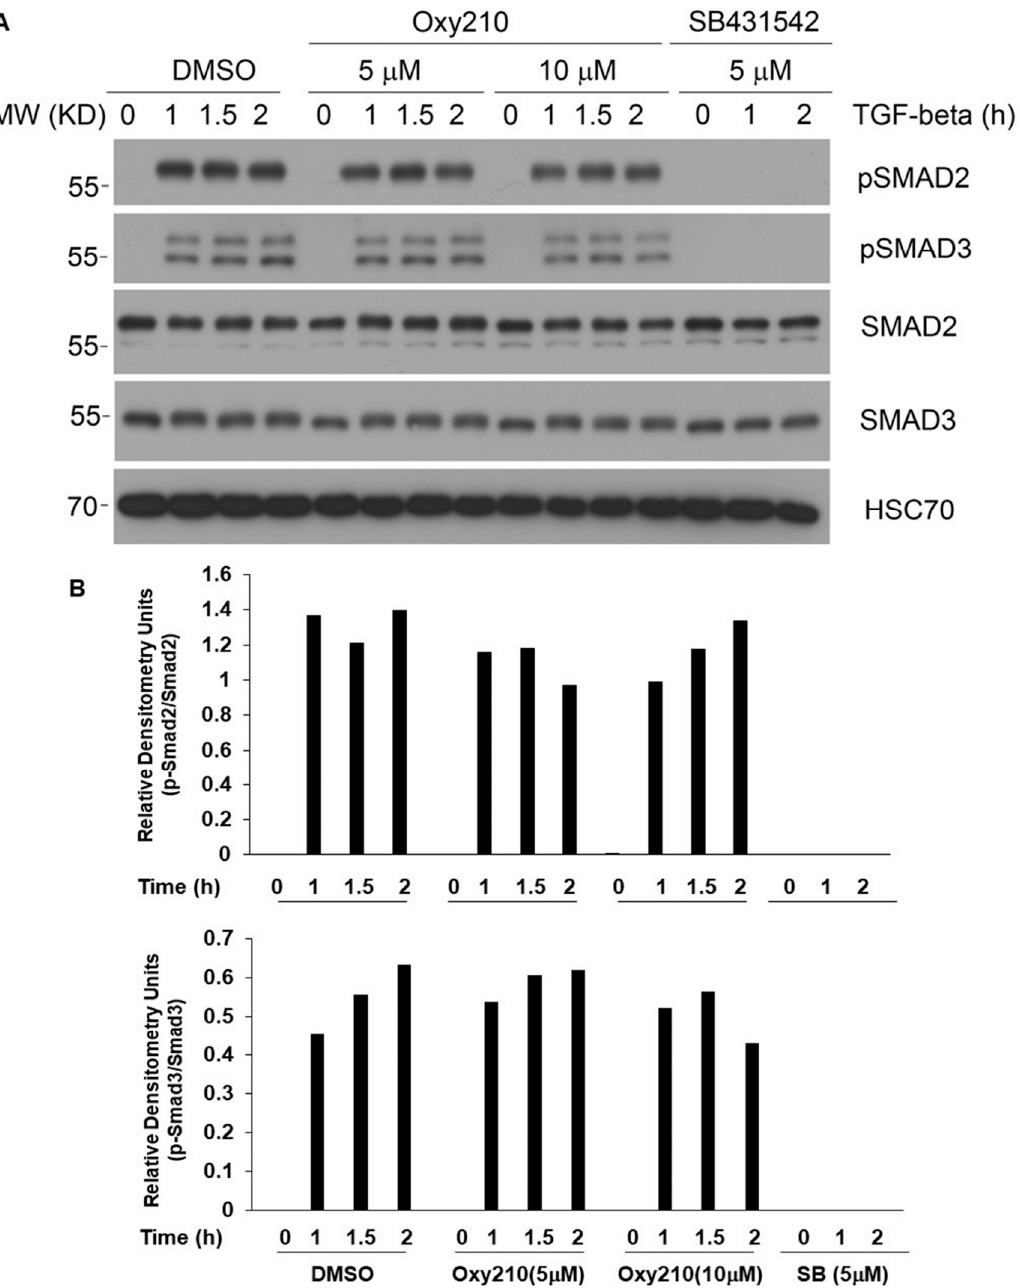
Figure 14. Effects of Oxy210 on TGF- β induced Smad2/3 phosphorylation. ( A ) RAW264.7 cells were pretreated with DMSO, Oxy186, Oxy210, or SB431542 overnight, and then treated with TGF- β (10